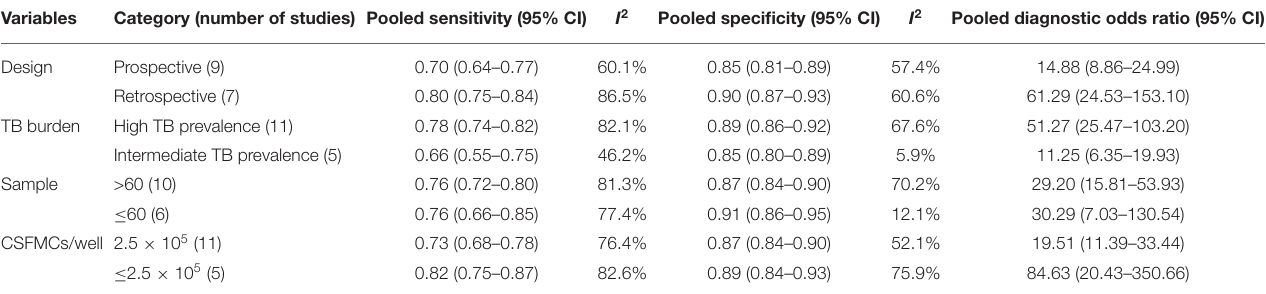
FIGURE 6 | SROC curves for T-SPOT in the (A) PB and (B) CSF for TBM diagnosis. Each study included in the meta-analysis is shown as a solid dot. Numbers indicate the included numbers of studies. Regression SROC curves summarize the overall diagnostic accuracy. PB, peripheral blood; CSF, cerebrospinal fluid; TBM, tuberculous meningitis; SROC, summary receiver operating characteristic.